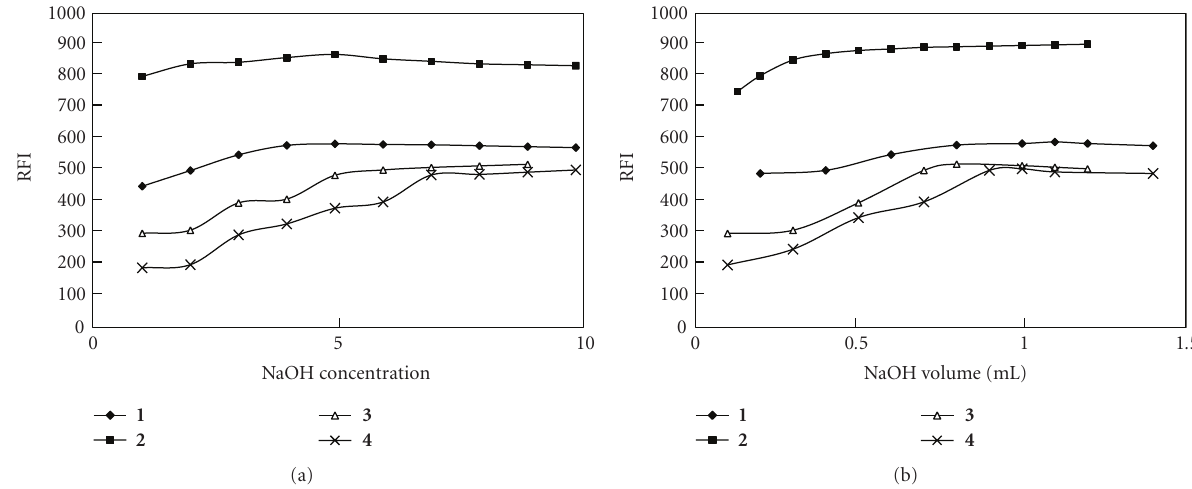
Figure 2: E ff ect of NaOH concentration and volume on fluorescence intensity of the reaction product of 1–4 with NMNCl. The variation of NaOH concentration is made at constant volume and that of NaOH volume at constant